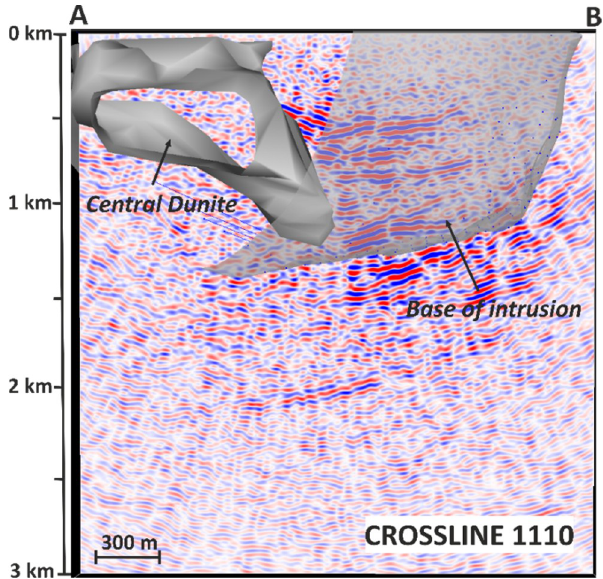
Figure 2. Internal reflectivity within the Kevitsa intrusion: Crossline 1110 (See location for A – B from Figure 1) of the 3D seismic cube (migrated; [18]). Interpreted base of the Kevitsa intrusion and central dunite unit [20] are shown as a reference. The internal reflectivity is located beneath, and spatially restricted by, the Kevitsa resource area.